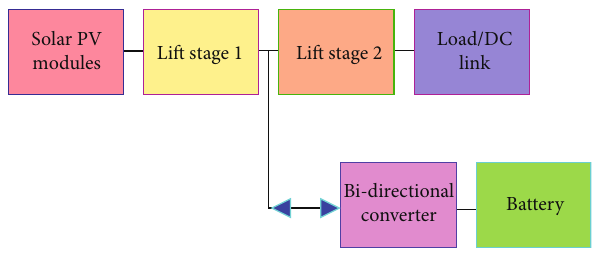
Figure 1: Block diagram of the proposed